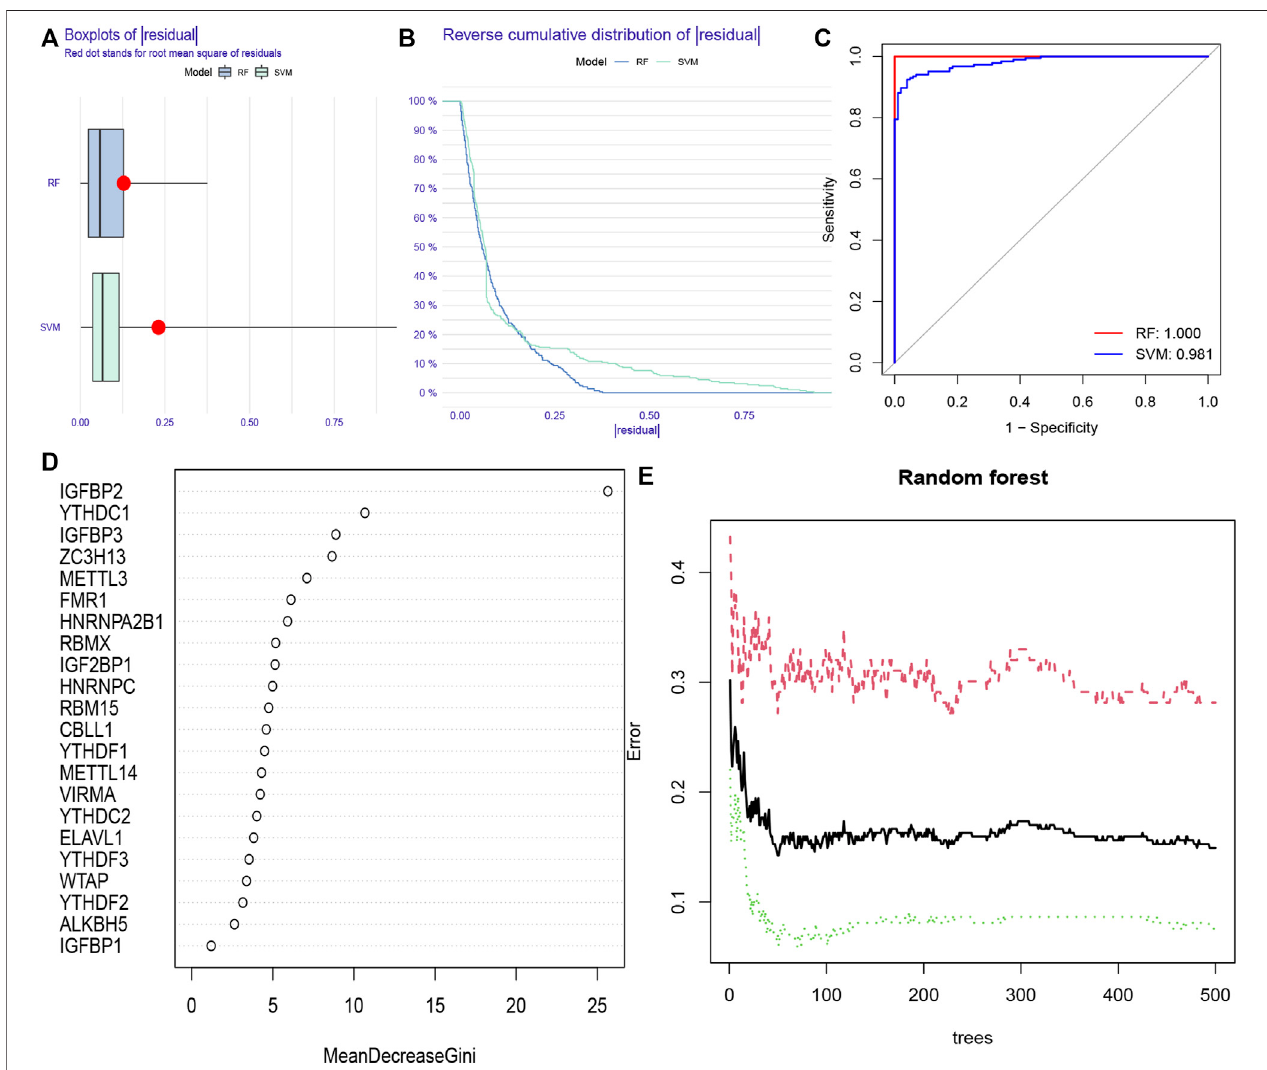
FIGURE 3 | Random forest (RF) model and support vector machine (SVM) model construction (A) RF model showed a lower residual value in the boxplots of residual. (B) Reverse cumulative distribution of residual was plotted to show the residual distribution of RF and SVM model (C) RF model and SVM model displayed a favorable predictive value, with an AUC of 0.981 for SVM, and 1.000 forRF. (D) The importance ofthe 22 RNAN6-methyladenosine regulators wascalculated based on theRFmodel,includingthetop fi veregulators(IGFBP2,YTHDC1,IGFBP3,ZC3H13,andMETTL3) (E) Thethreecurvesrepresentedtheerrorlevelsoftreatgroups (red line), control groups (green line), and overall samples (black line),